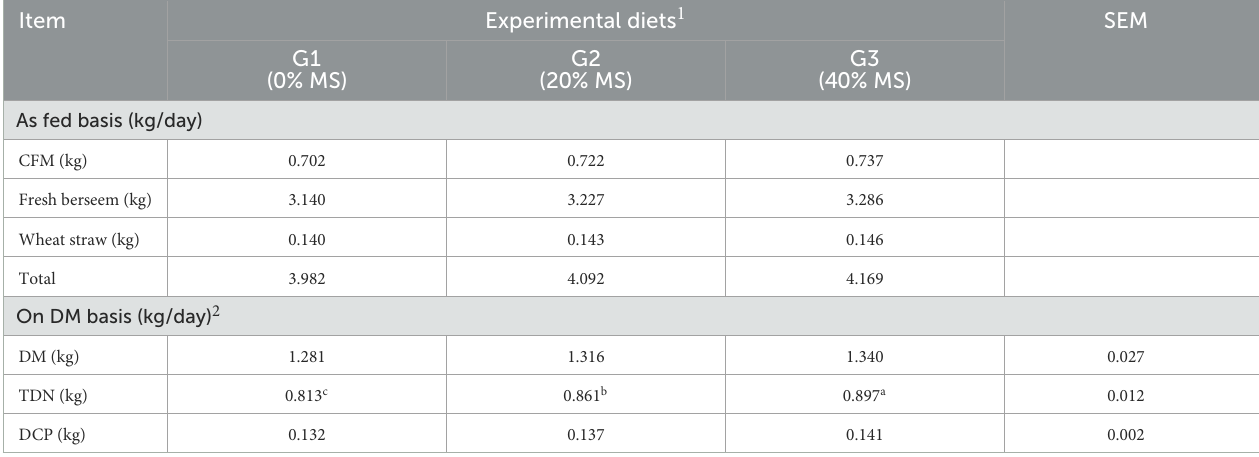
TABLE 5 Average daily feed intake ratio of the tested diets by female kids in the experimental